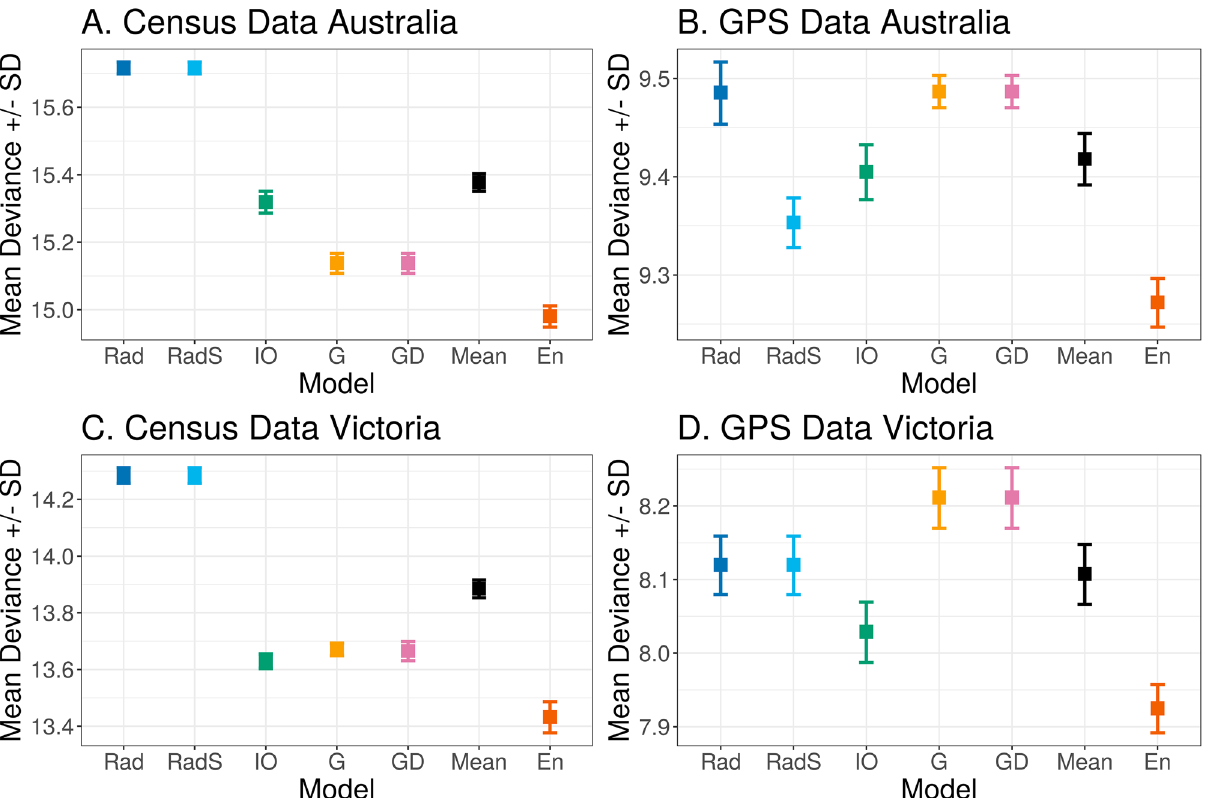
Figure 2. Comparison of mean deviance between models for each dataset and geographic scale. Legend: G = gravity model; GD = gravity with distance model; Rad = radiation model; RadS = radiation with selection model; IO = intervening opportunities model; En = ensemble model; Mean = mean deviance across all model types. Note the y-axis is on a log scale and the absolute value of the deviance is not comparable between